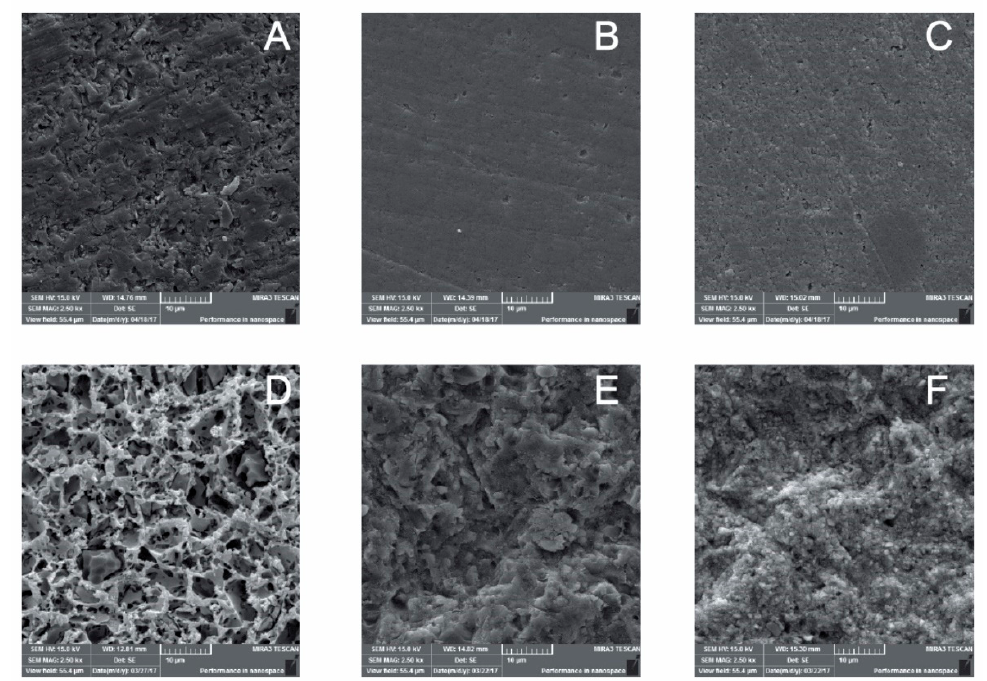
Figure 4. Representative SEM photomicrography of untreated ( A – C ) and treated ( D – F ) surfaces of VE, LU, and BR CAD–CAM composites (2500 × ).